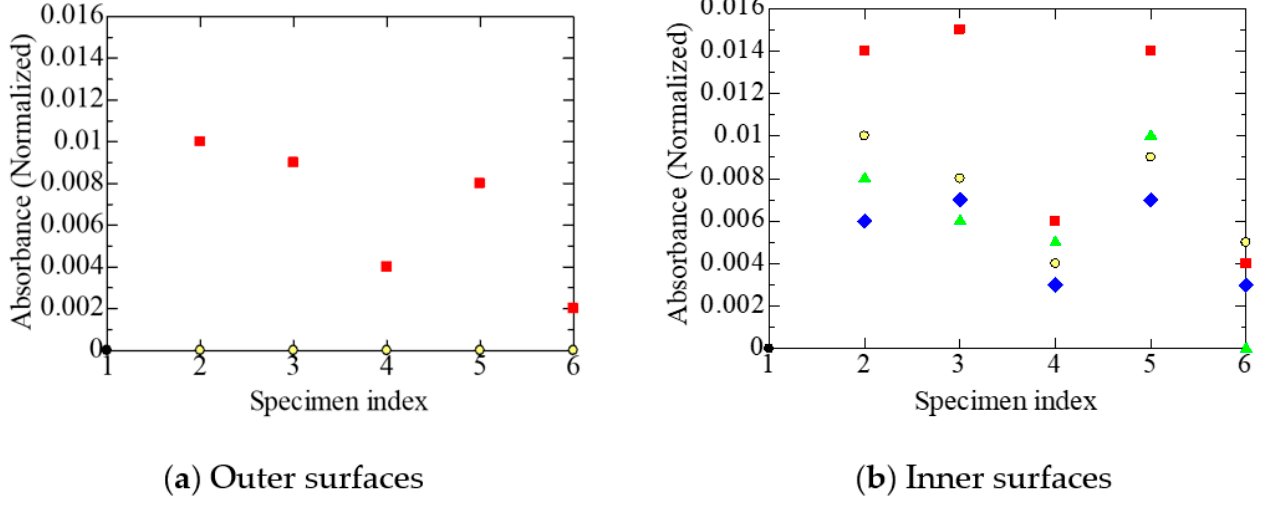
Figure 5. Normalized absorbance due to ester carbonyl measured at each stage on various tubular specimens. Refer to Tables 1 and 2 and Figure 4 for the meanings of the numerals on the abscissa and sample symbols. Except for A1 and its treated stages, the absorbance in Figure 5a is null.